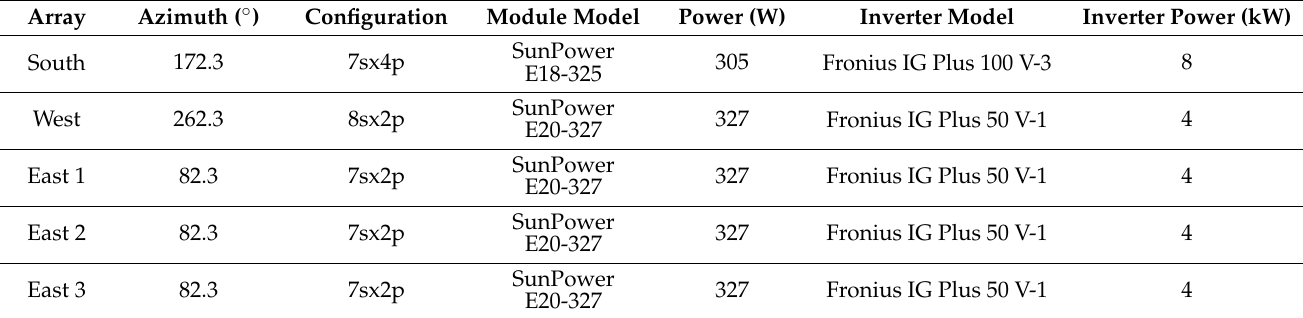
Figure 1. Pictures of Building 42 showing the three façades with the five arrays: west and south façades ( a ), and east façade ( b ). Table 1. Technical data of the monitored BIPV